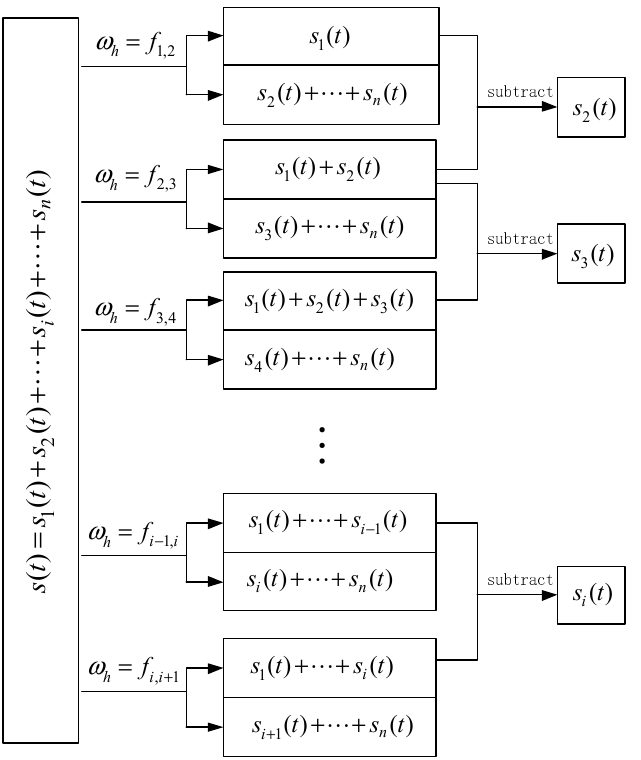
Figure 2. AMD (analytical mode decomposition) signal extraction principle diagram.